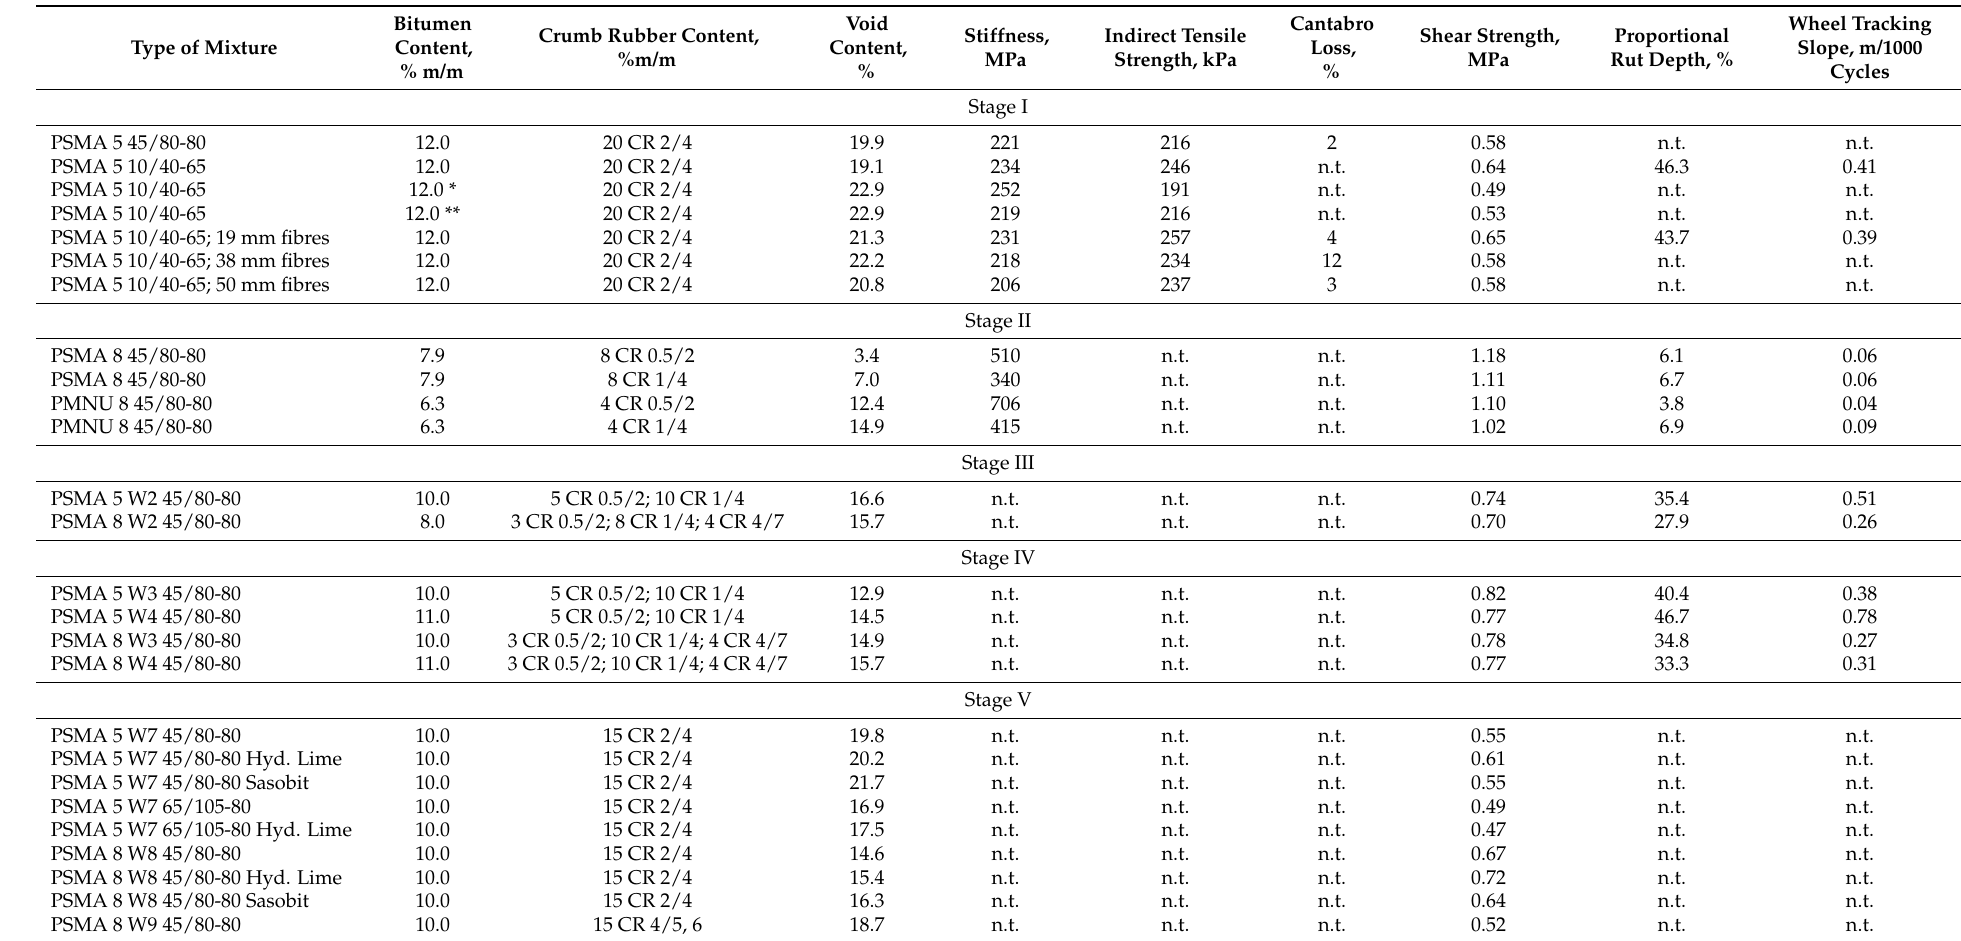
Table 5. Summary of laboratory test